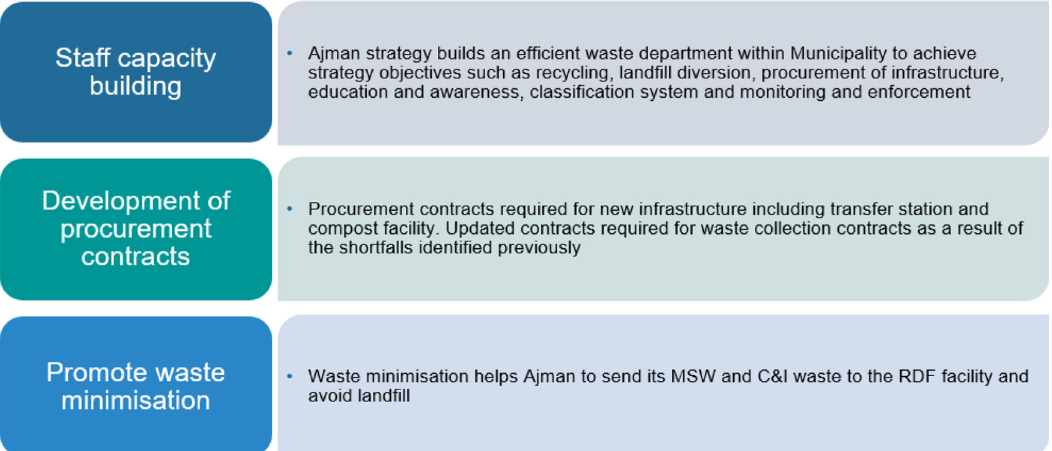
Fig. 11. institution and Governance strategy and framework.